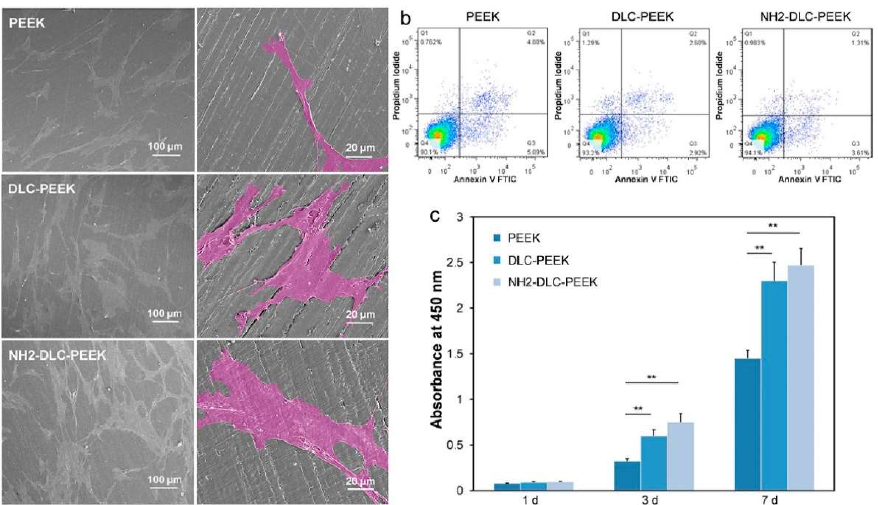
Figure 4. Represents in vitro cytocompatibility of DLC coated PEEK substrates, ( a ) surface morphol- ogy of hBMSC cultured on PEEK, DLC-PEEK, and NH2-DLC-PEEK substrates for 1 day, and the enlarged cells are shown in pseudo-color, ( b ) cell viability for 1 day, and ( c ) proliferation of hBMSCs after culturing samples for 1 d, 3 d, and 7 days [235]. ** denotes p < 0.01